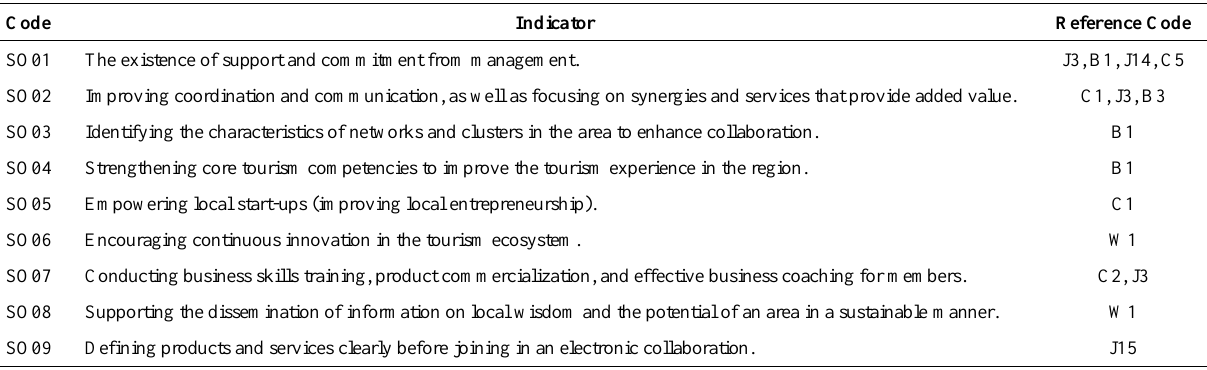
Table 5. The SO Strategy (The Strength-Opportunity Strategy).